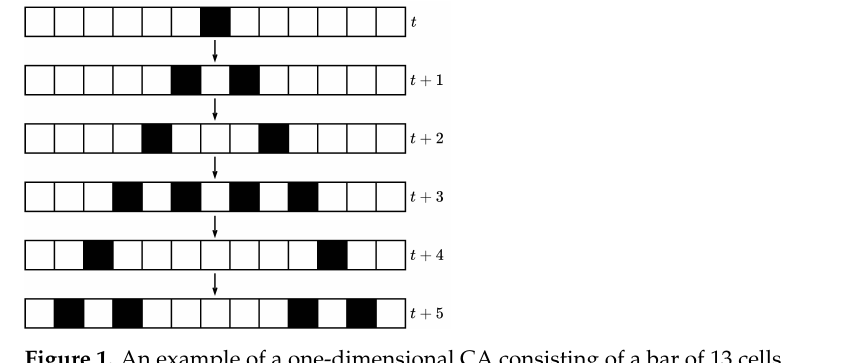
Figure 1. An example of a one-dimensional CA consisting of a bar of 13 cells.